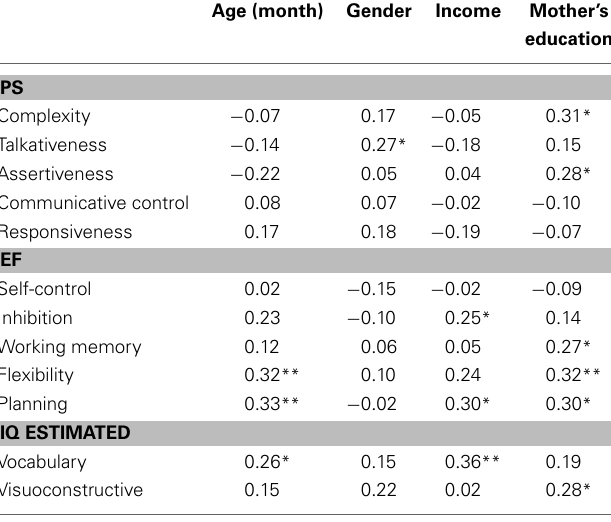
Table 3 | Pearson correlations between sociodemographic characteristics and executive functions (EF), intellectual quotient (IQ), and pragmatics skills (PS)